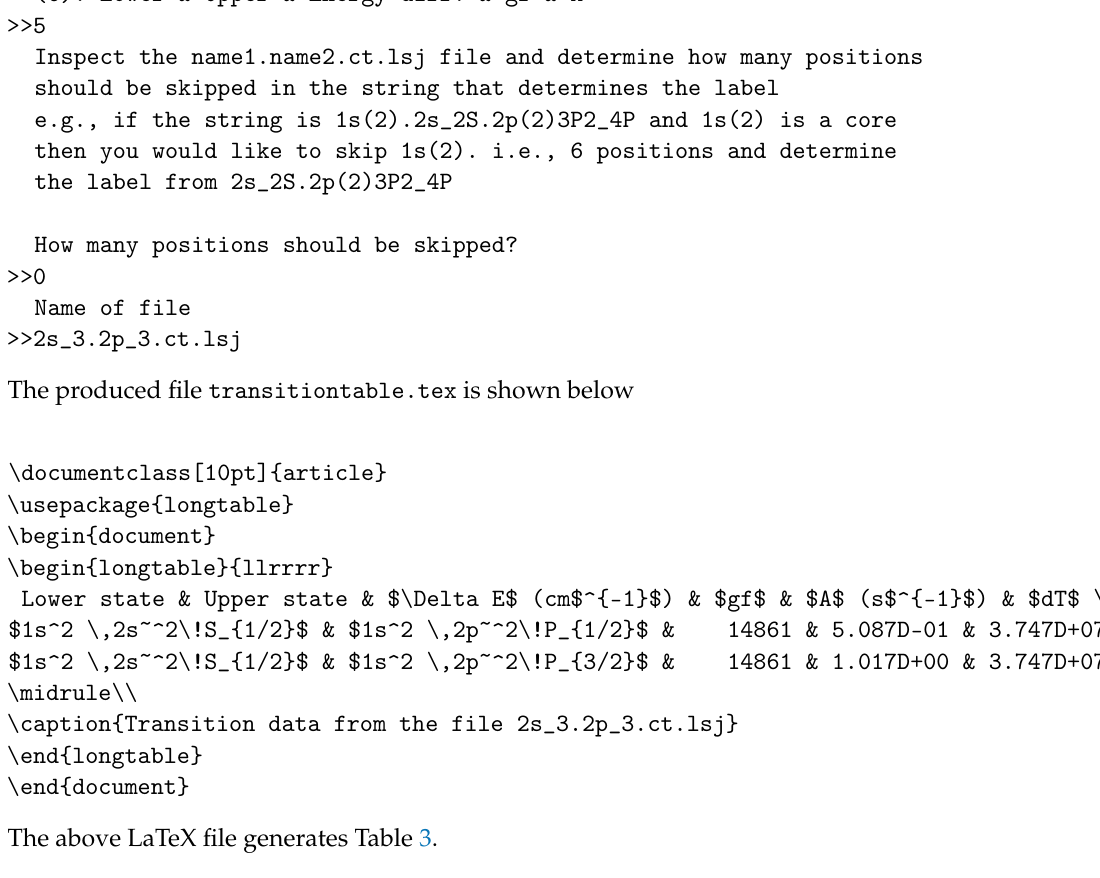
Table 3. Transition data from the file 2s_3.2p_3.ct.lsj